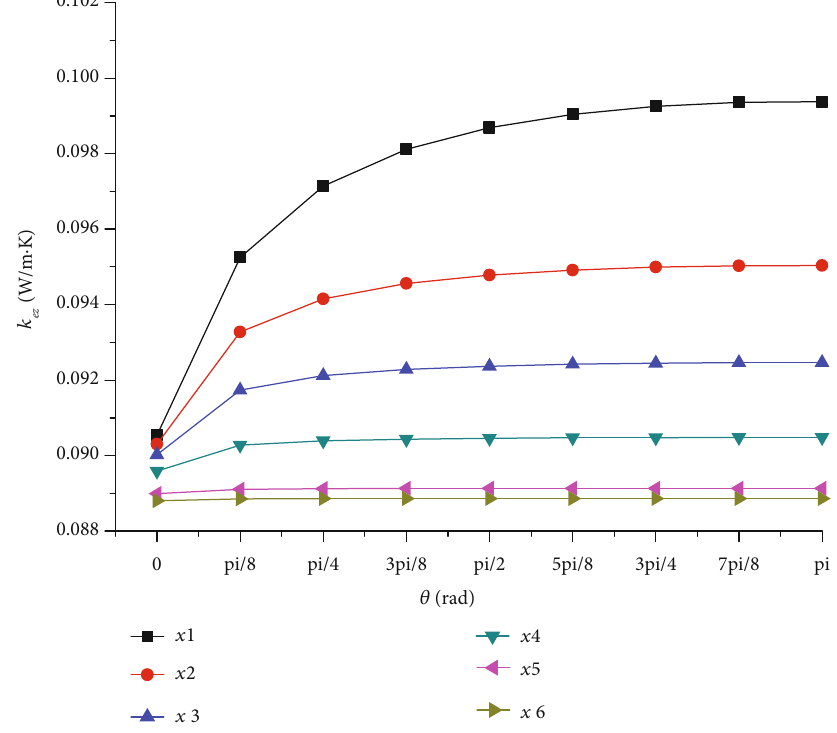
Figure 28: E ff ect of fi ber volume fraction and fi ber angle on thermal